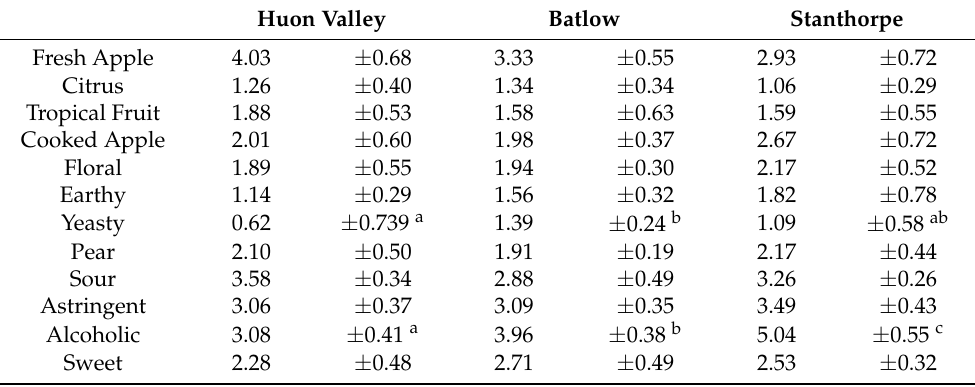
Table 3. Sensory profiles of “Fuji” cider made from apples grown from three different regions represented by mean aroma and taste intensities ± standard error of the mean for each attribute ( n = 9). Different letters denote significant differences between means at p ≤